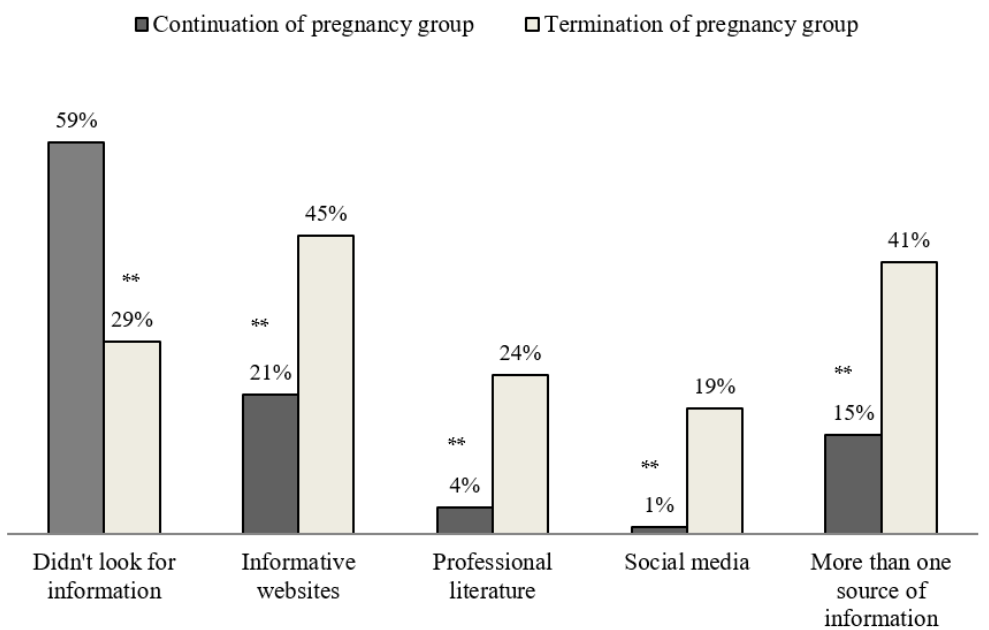
Figure 2. Utilization of information sources—comparison between ‘continuation of pregnancy’ and ‘termination of pregnancy’ groups; ** p < 0.001.